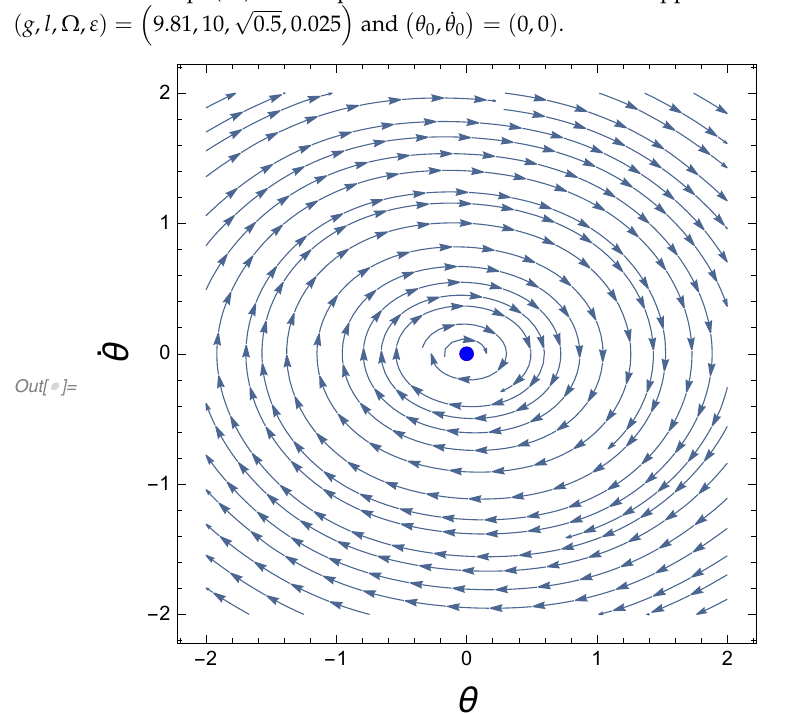
Figure 4. The phase portrait to the dynamical system of the i.v.p. (21) near the equilibrium point ( 0,0 ) is considered for ( g , l , Ω , ε ) =